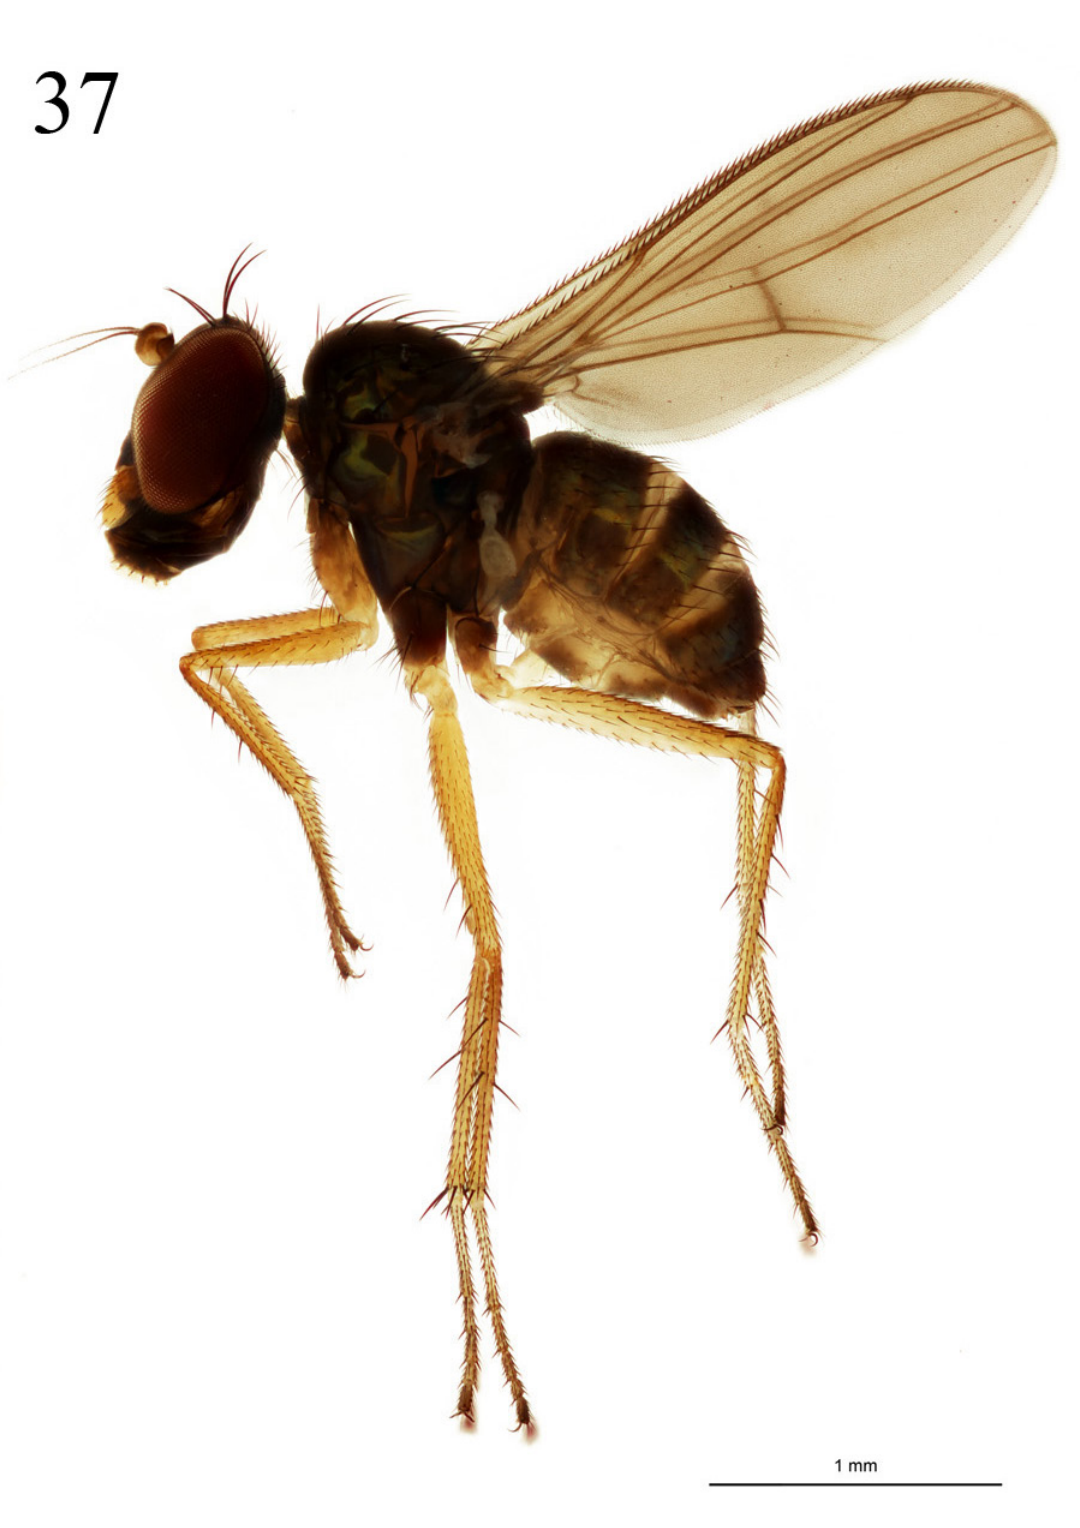
Fig. 37. Thinophilus variabilis sp. nov., ♀,